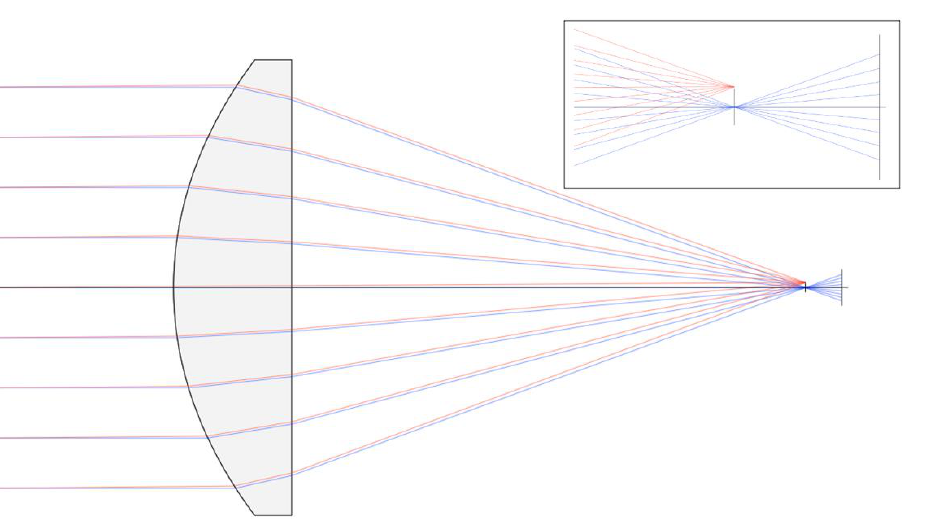
Figure 2. Ray-tracing model of the light path through the scanner telescopes (SWIR lens is shown). The vertical line at the lens focal plane represents either the MWIR sensor or the aperture in the SWIR channel. The far-right vertical line represents the SWIR sensor. Blue lines trace the path of incident light rays that are parallel to the lens axis. Red lines trace the path of light arriving from 0.5° off-axis. As shown, the 0.5° off-axis rays either miss the MWIR sensor or are blocked by the SWIR aperture (inset).